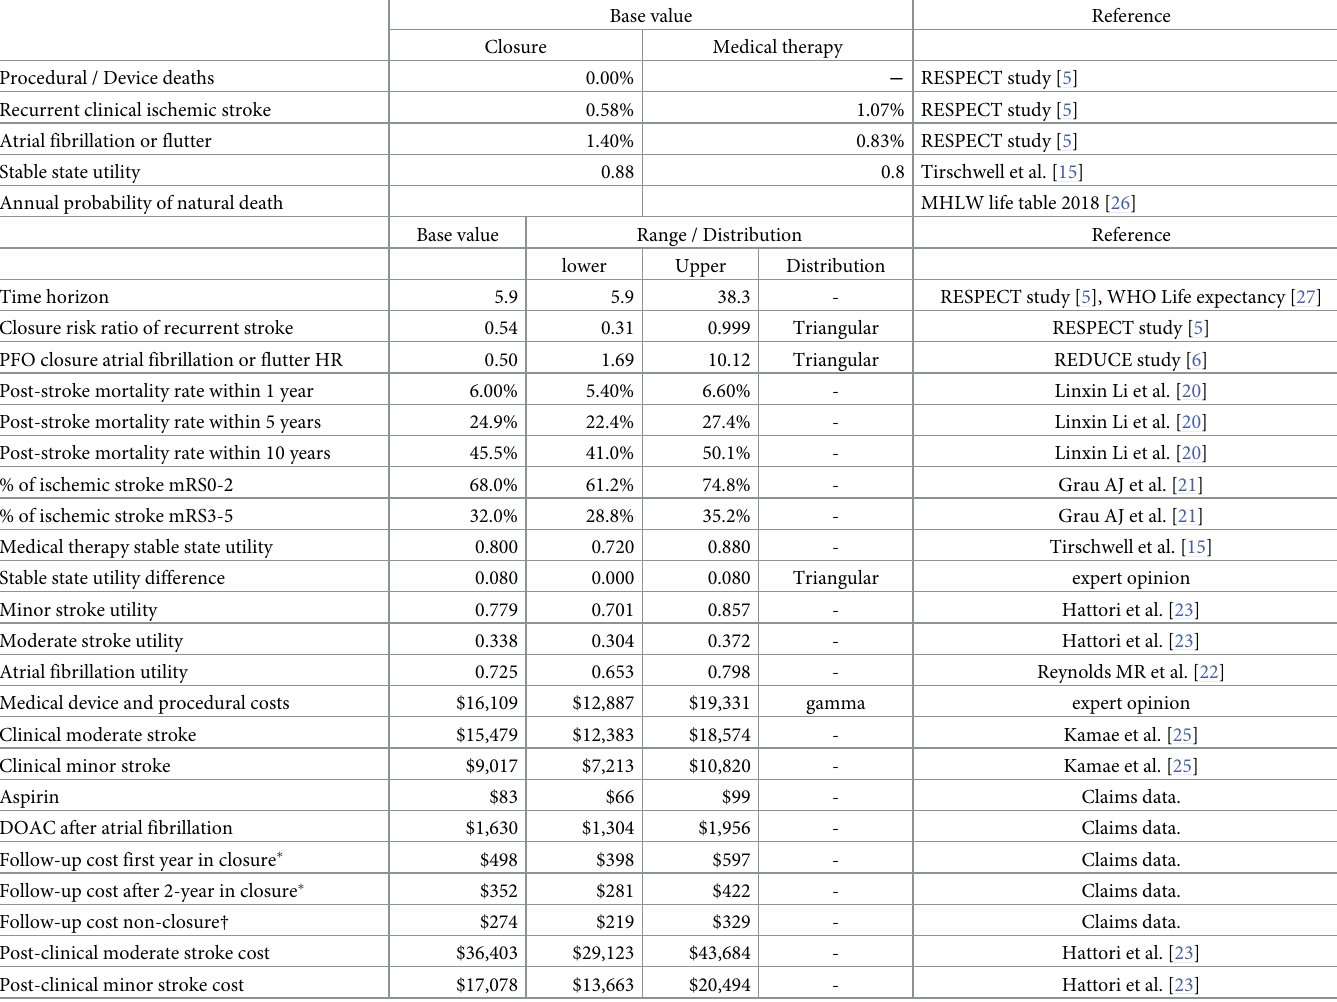
Table 1. Probabilities of events, life years, and utility scores for base model inputs and sensitivity